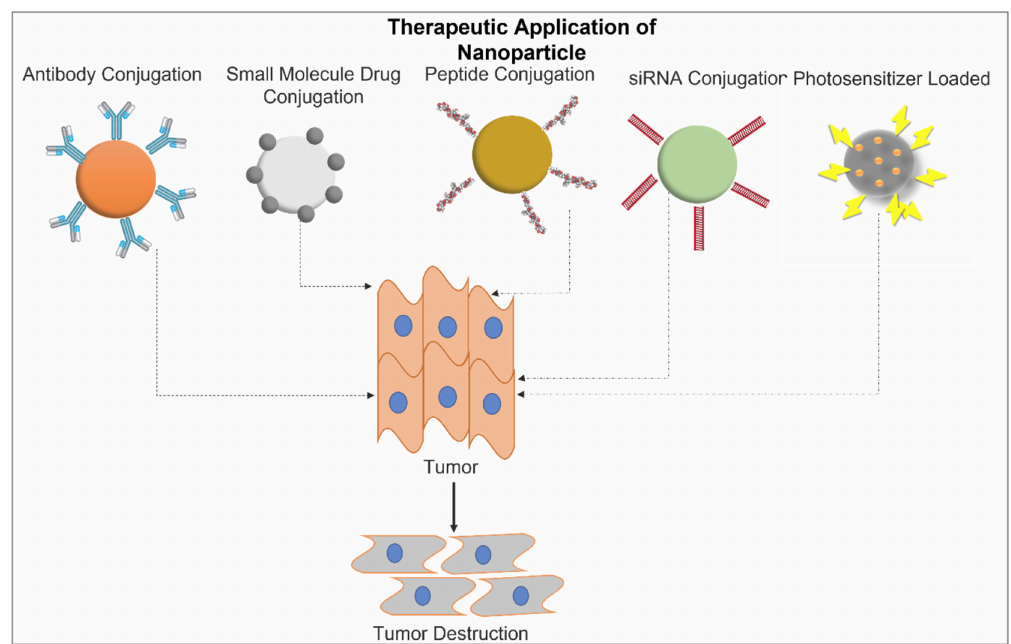
Figure 3. Surface modification of metallic/metalloid NPs for cancer